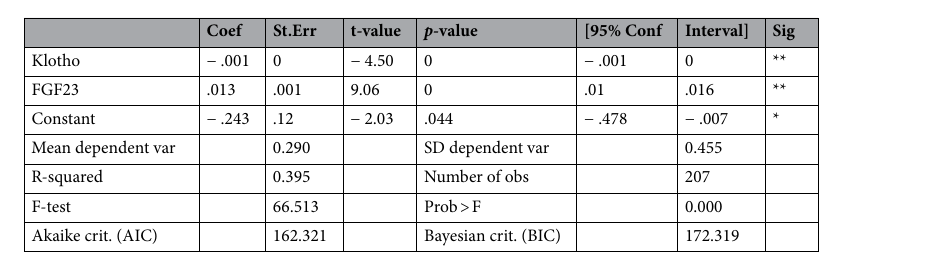
Table 2. Multivariable logistic regression for MACE. ** p < .01, * p <